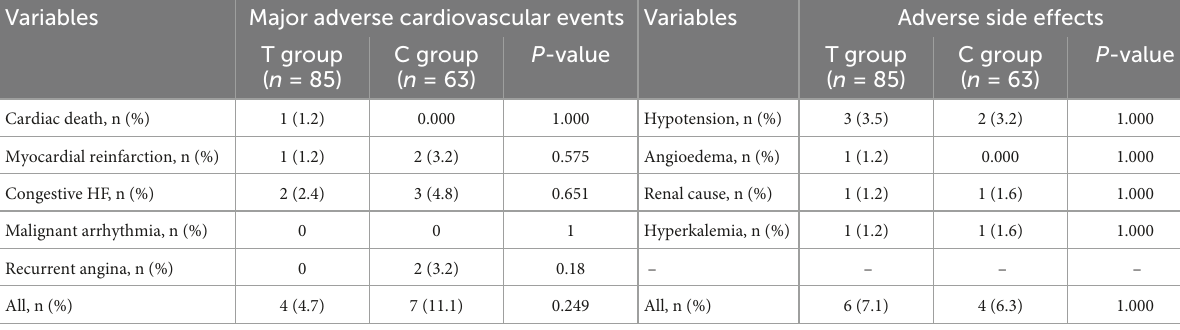
TABLE 4 Major adverse cardiovascular events and adverse side effects between the two groups. Variables Major adverse cardiovascular events